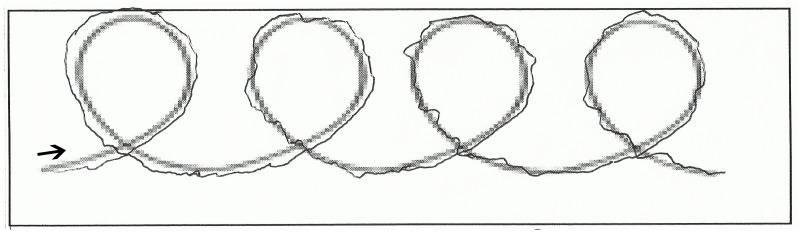
Handwriting task.